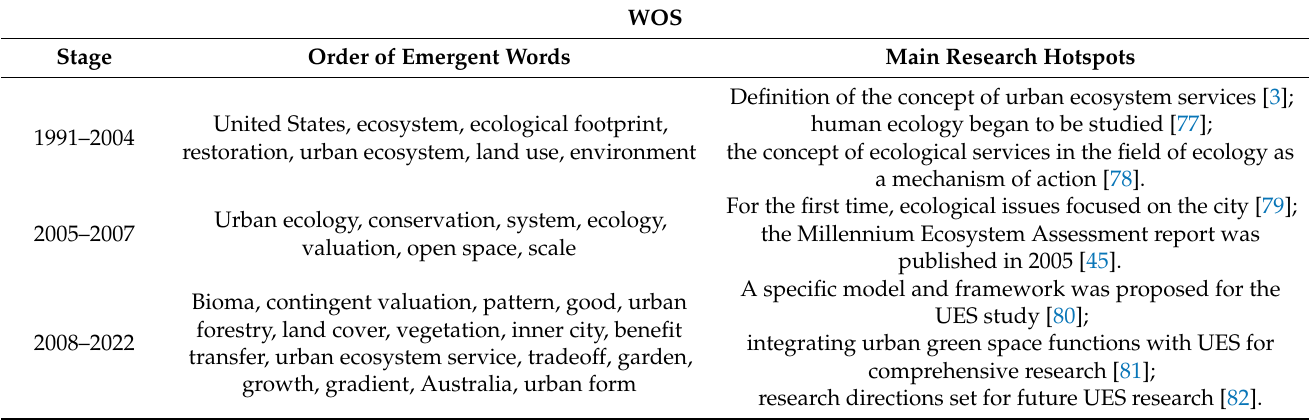
Table 7. Keyword evolution analysis for